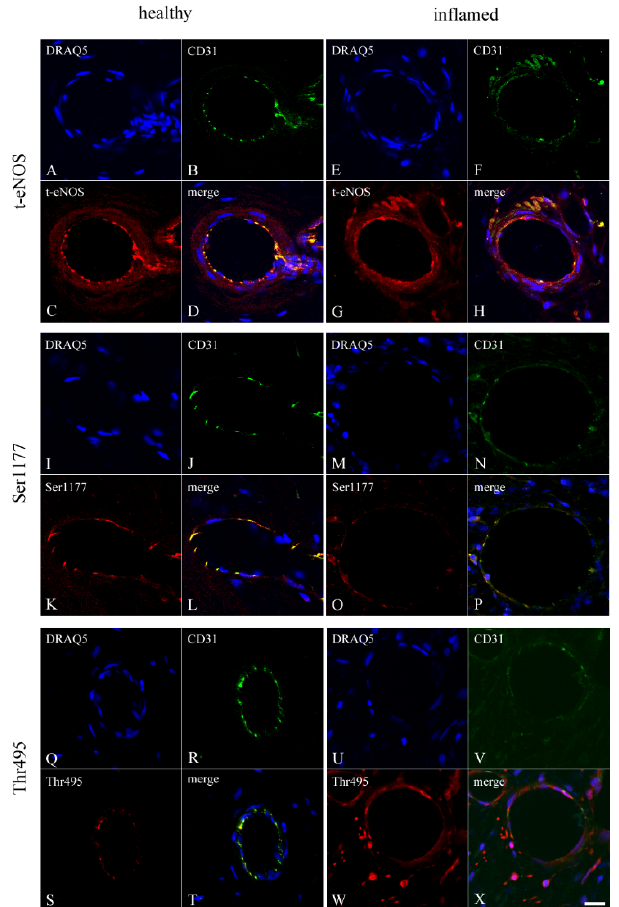
Figure 2. The co-localization of CD31 with eNOS, Ser1177, and Thr495 in blood vessels of the healthy and inflamed human dental pulp. The nuclei of the dental pulp cells are visible by DRAQ5 (a chromosome marker) ( A ). In the endothelium of the pulpal blood vessels, CD31 (a marker for endothelium) ( B ) and t-eNOS ( C ) are co-localized ( D ). The healthy ( C , D ) and inflamed ( G , H ) vascular smooth muscle cells also show a weak staining intensity for t-eNOS. In capillaries of the inflamed dental pulp, CD31 ( F ) and t-eNOS ( G ) are colocalized ( H ). The cell nuclei of the inflamed dental pulp are identified by DRAQ5 staining ( E ). In endothelium of the inflamed pulpal blood vessels, CD31 ( F ) with a weak staining intensity and t-eNOS ( G ) with a moderate staining intensity are co-localized ( H ). In nuclei of the healthy pulpal cells, DRAQ5 is localized ( I ). CD31 ( J ) and Ser1177 ( K ) are co-localized ( L ) in the endothelium of the healthy dental pulp. The nuclei of cells of the inflamed dental pulp are stained by DRAQ5 ( M ). In endothelium of the inflamed pulpal blood vessels, CD31 ( N ) and Ser1177 ( O ) are co-localized ( P ) with a weak staining intensity. DRAQ5 is identified in nuclei of the healthy pulpal cells ( Q ). In endothelium of the healthy pulpal blood vessels, moderate staining for CD31 ( R ) and weak staining intensity for Thr495 ( S ) was co-localized ( T ). DRAQ5 is detected in nuclei of the inflamed dental pulp cells ( U ). In endothelium of the inflamed pulpal blood vessels, a weak staining for CD31 ( V ) and a strong staining intensity for Thr495 ( W ) are co-localized ( X ). In a subpopulation of the inflamed dental pulp cells, Thr495 is also visible ( W , X ). Scale bar: ( A – X ) = 20 µ